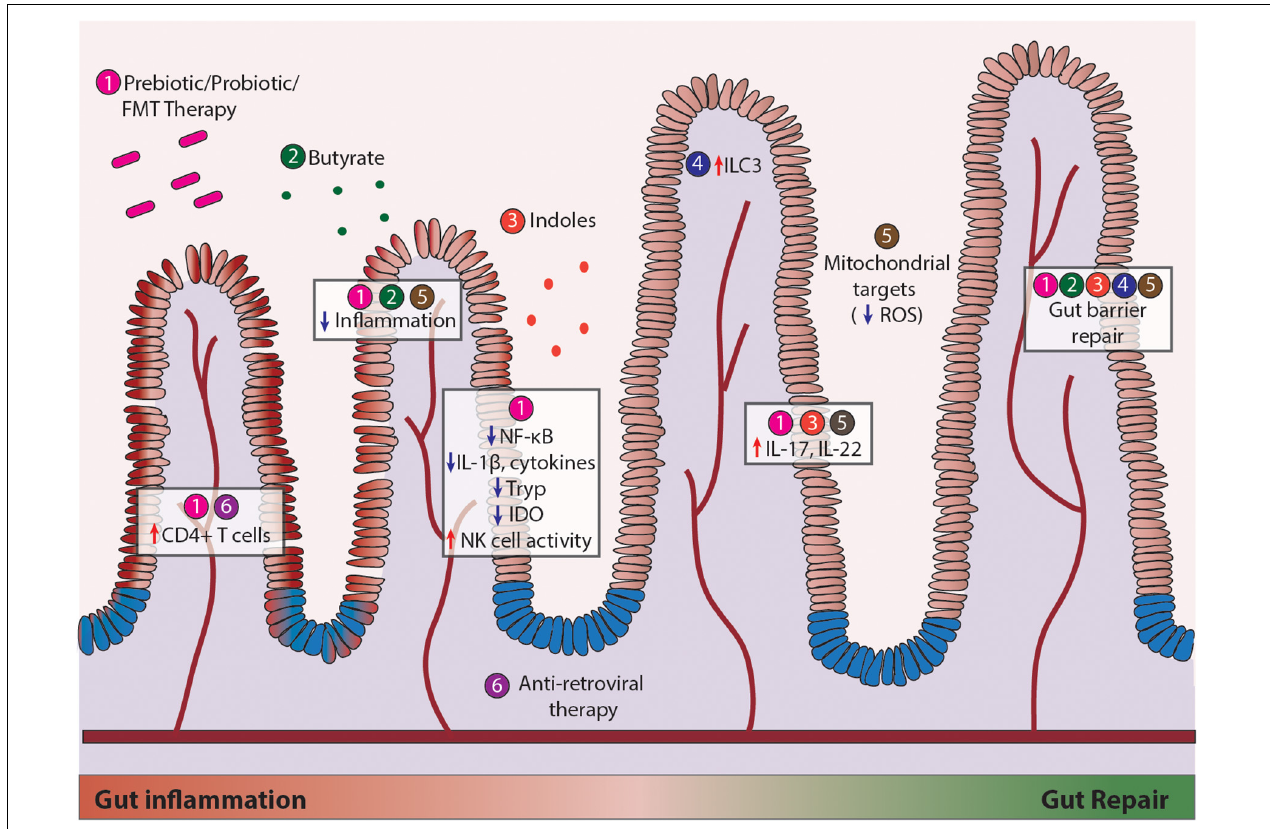
FIGURE 2 | Current therapeutic modalities to repair mucosal damage during HIV and SIV infection. Strategies include (1) recovery of gut microbial communities, (2) prebiotic stimulation using butyrate, (3) addition of bacterial metabolites such as indoles, (4) enhancing host immune cell function through innate lymphoid cells (ILC), (5) combating cellular metabolism through mitochondrial targets such as ROS, and (6) anti-retroviral therapy (ART). Efforts made in regard to each strategy (Heise et al., 1993, 1994; Lim et al., 1993; Veazey et al., 1998; MacDonald and Monteleone, 2005; Lathrop et al., 2011) have led to modest increases in CD4 + T cell numbers, reduced inflammation, increased NK cell activity, enhanced IL-17/IL-22 production, and gut epithelial barrier